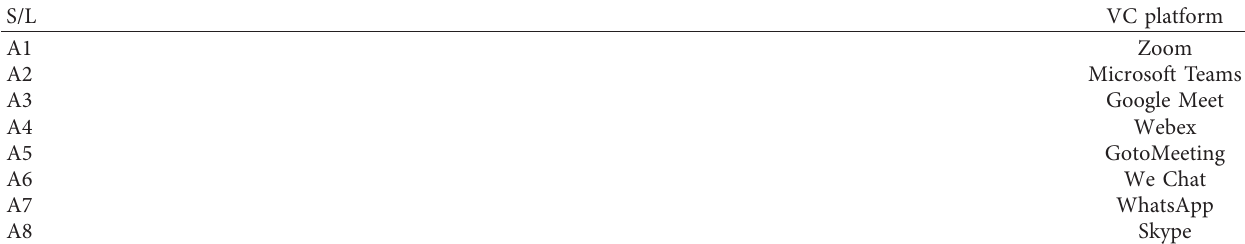
Table 2: List of VC platforms under comparison.